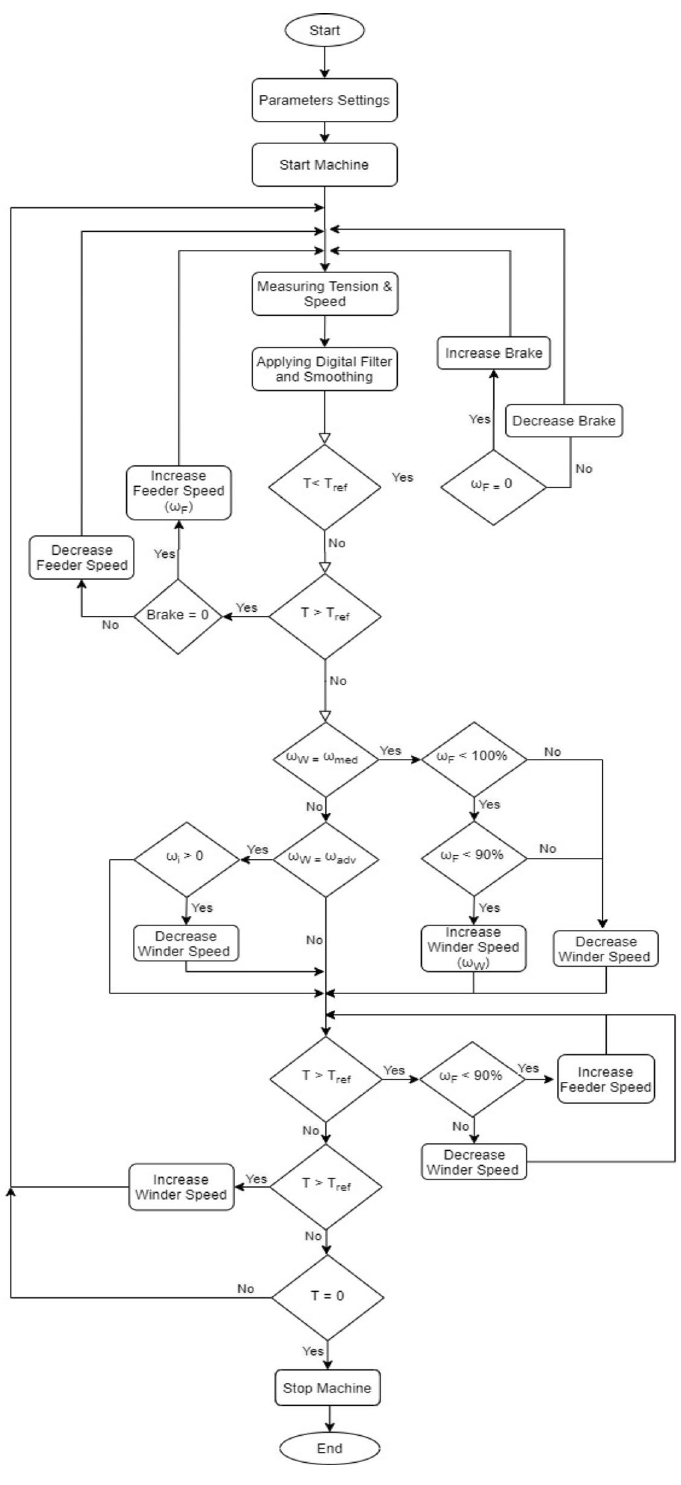
Figure 7. Controller flow